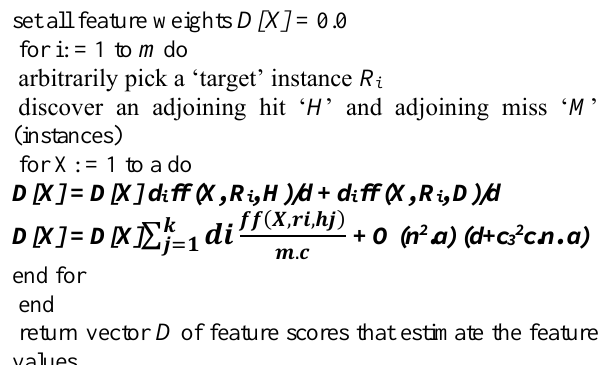
Algorithm1: Pseudocode for the enhanced Relief-F